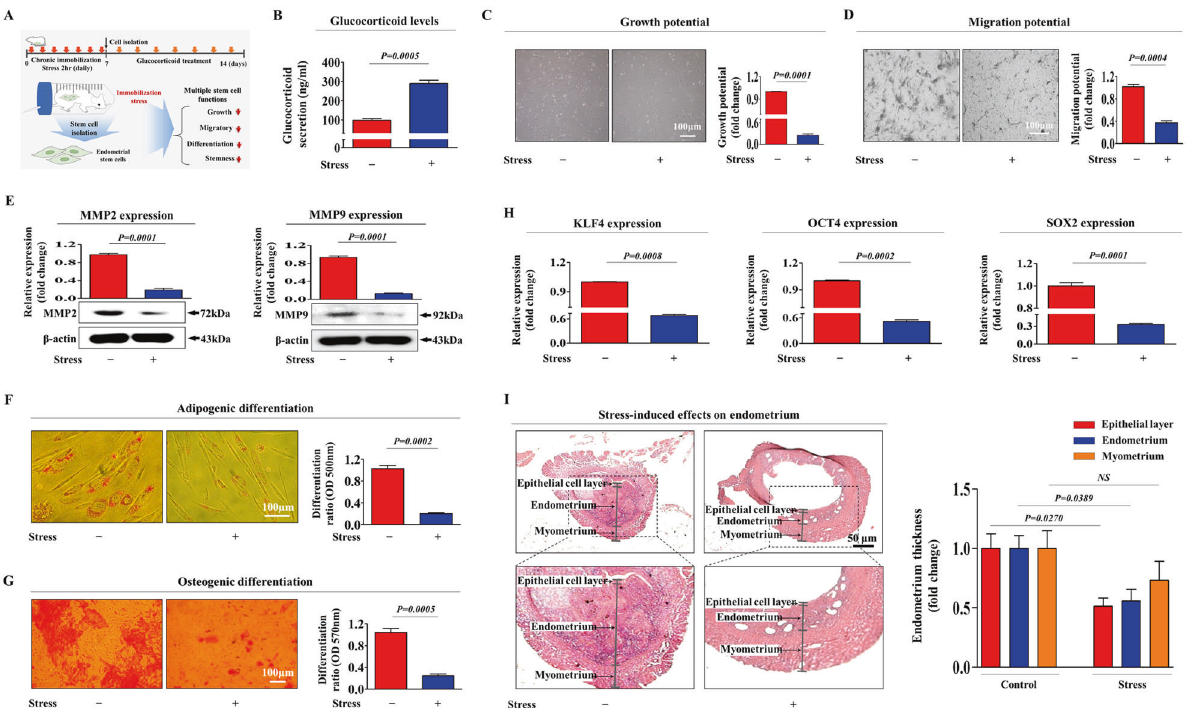
Fig. 7 CIS-induced glucocorticoids signi fi cantly suppress various regenerative capacity-related functions of endometrial stem cells in vivo. A schematic diagram of the experimental protocol as mentioned in the materials and methods section is described ( A ). The mice were exposed to chronic immobilization stress (CIS, 2 h daily for 7 days), and then endometrial stem cells were isolated from the uterine endometrium. Isolated stem cells were cultured and expanded in vitro with continuous exposure to glucocorticoids (500 nM) to properly mimic physiological conditions of stress-induced glucocorticoid secretion. Compared with the control mice, mice subjected to immobilization-induced chronic stress exhibited a signi fi cant increase in glucocorticoid secretion into the peripheral circulation ( B ). The subsequent changes in endometrial stem cell proliferation were assessed by MTT assays. The percentage (%) of proliferating stem cells was calculated relative to the number observed in the vehicle control ( C ). The CIS-induced changes in stem cell migration in vivo were analyzed by transwell assays ( D ) and western blotting with MMP-2 and MMP-9 antibodies ( E ). The effects of CIS-induced glucocorticoids on adipogenic ( F ) and osteogenic ( G ) differentiation in vivo were assessed by oil red O and alizarin red staining, respectively. The relative quanti fi cation of secreted calcium deposition and lipid droplet (LD) formation within differentiated cells was estimated by analyzing the absorbance of the solubilized cells at 500 nm and 570 nm, respectively. Real-time PCR results revealed CIS-induced in vivo changes in the expression of several pluripotency-related transcription factors (KLF4, OCT4, and SOX2) ( H ). Uterine endometrial tissue samples from CIS-induced mice were collected and subjected to hematoxylin and eosin (H&E) staining. Histological examination revealed that the endometrial functional layer was signi fi cantly decreased by CIS-induced glucocorticoid treatment ( I ). β -actin was used as an internal control. HPRT was used as a housekeeping gene for real-time PCR analysis. All experiments were performed in triplicates, and the data has been presented as mean ± standard deviation (SD). P -value under 0.05 was presented in fi